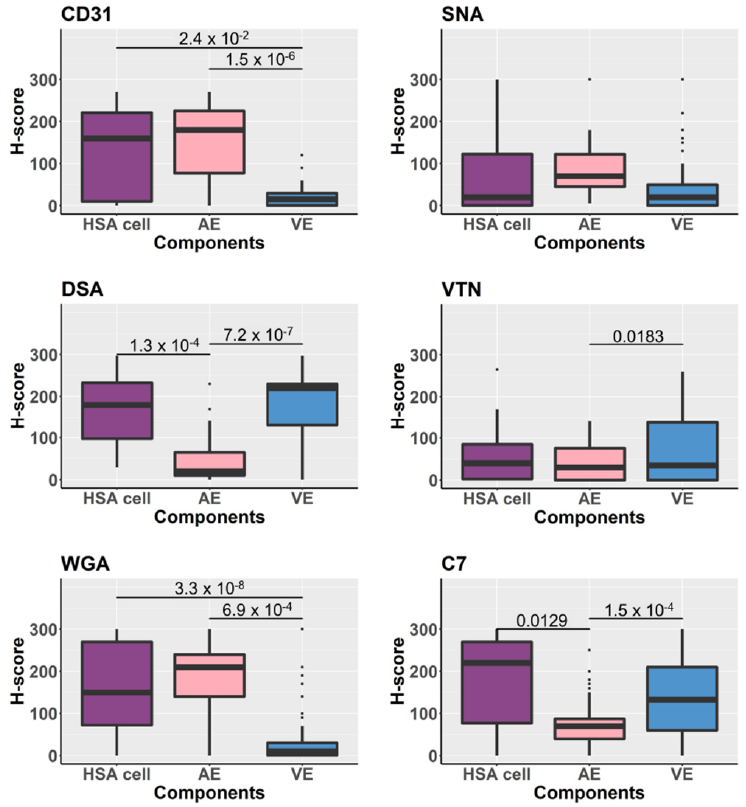
Figure 4. Boxplots demonstrate the comparison of H-scores assessed from lectin-histochemistry (DSA, WGA, SNA) and immunohistochemical (CD31, VTN, C7) labelling of tissue samples. The statistical analysis was performed by comparing H-scores between tissue components—HSA/cancer cells, arterial endothelium (AE) and venous endothelium (VE). Significance bars show only p -values < 0.05 derived from Wilcoxon test and adjusted by Bonferroni corrections.